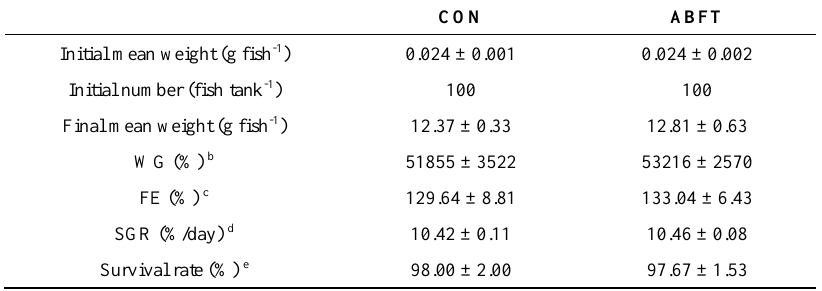
a Values are means from triplicate groups of fish where the values in each row with different superscripts are not significantly different ( P > 0.05)